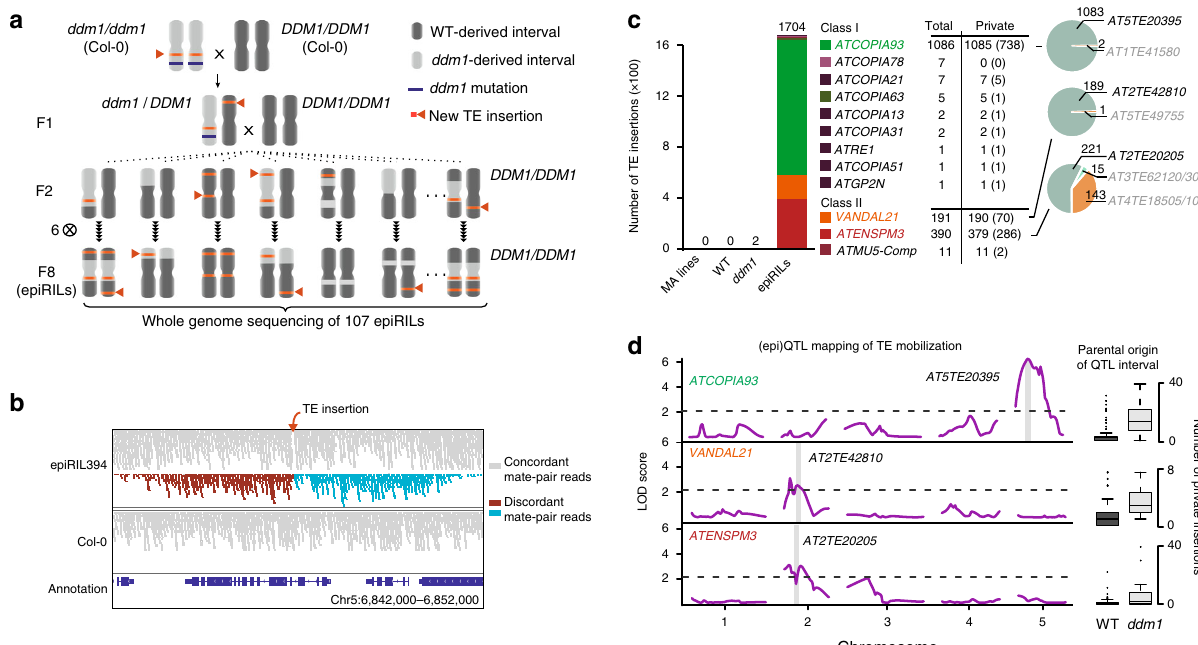
Fig. 1 TE insertions accumulate in the epiRILs. a Crossing scheme used to generate the epiRIL population. b Sequencing alignment tracks for epiRIL 394 and Col-0. Concordant and discordant mate-pair reads, as well as the sense or antisense orientation for the latter, are indicated in gray, brown and cyan, respectively c Number and identity of insertions accumulated in wild-type, ddm1 and the epiRILs. Number of hemizygous insertions are indicated in brackets. Pie charts show the proportion of insertions matching different full-length reference TE sequences. d (epi)QTL mapping of the number of insertions produced by ATCOPIA93, VANDAL21 , and ATENSPM3 . The full-length reference TE sequence located within the single (epi)QTL interval in each case is indicated. Box-plots indicate the variation in the number of insertions in the epiRILs in relation to the parental origin of the relevant (epi)QTL interval. For each boxplot, the lower and upper bounds of the box indicate the fi rst and third quartiles, respectively, and the center line indicates the median. Source data of Figs. 1b and 1c are provided as a Source Data fi le